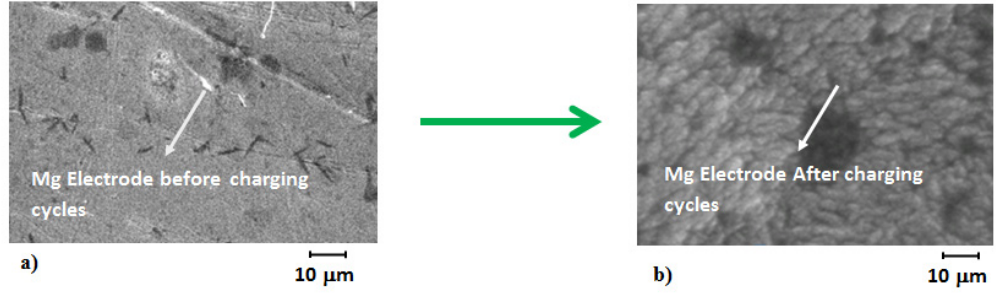
Figure 9. MgOx electrode micro-graphs by SEM ( a ) before and ( b ) after 17 cycles.